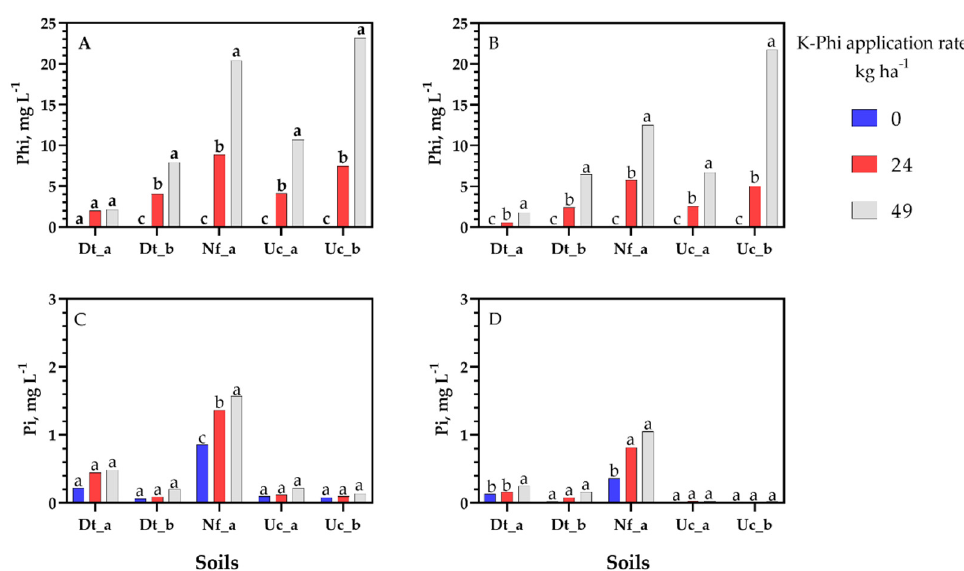
Figure 1. Mean phosphite-P (Phi) concentration in leachates from the first ( A ) and second leaching ( B ) trial; and mean phosphate-P (Pi) concentration in leachates from the first ( C ) and second leaching ( D ) trial for the five soils described in Table 1. Each soil received potassium phosphite (K-Phi) application rates equivalent to 0, 24, and 49 kg P ha − 1 before the first leaching trial. For each soil, means followed by the same letter are not significantly different at a probability p < 0.01.